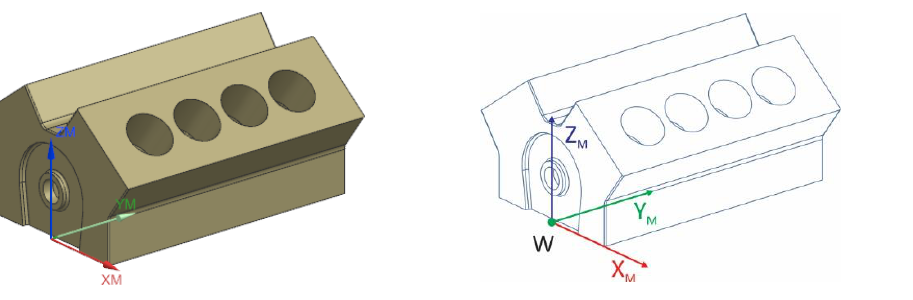
Figure 5. Kinematic model of the engine block.